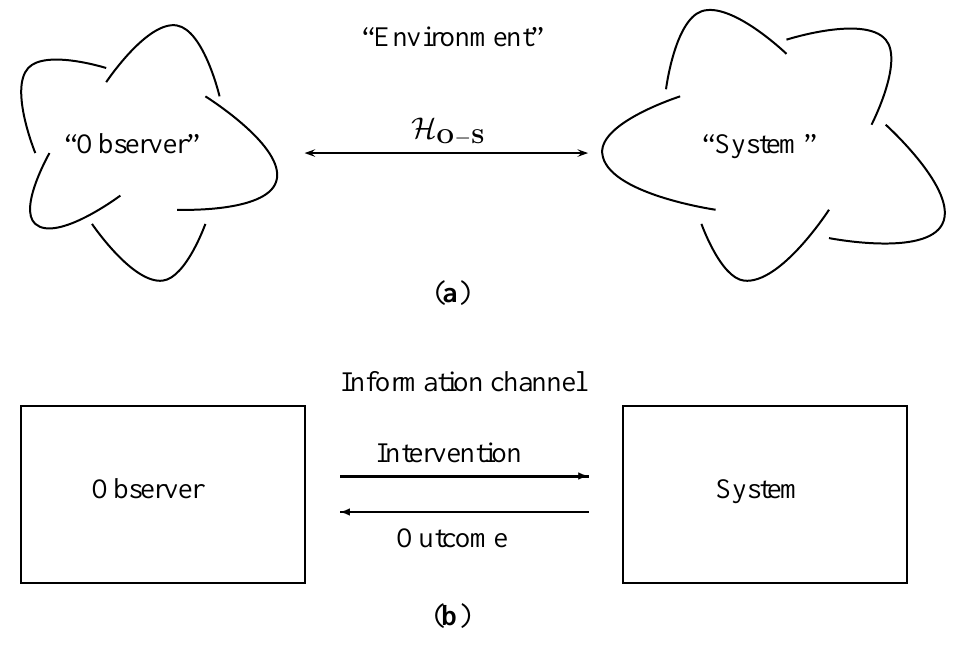
Figure 1. ( a ) A physical interaction O S between physical degrees of freedom regarded H − as composing an “observer” O and other, distinct physical degrees of freedom regarded as composing a “system” S , all of which are embedded in and interact with physical degrees of freedom regarded as composing the “environment” E . Boundaries are drawn with broken lines to indicate that they may not be fully characterized by experiments; ( b ) A two-way information transfer between an observer O and a system S via a channel C